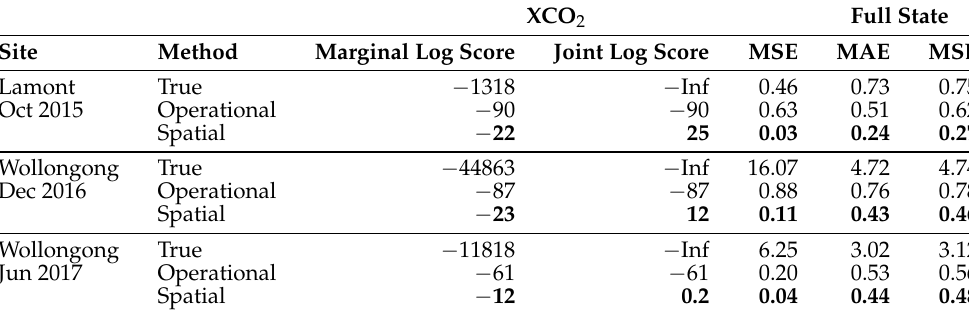
. 2 and the full state vector, as well as the mean 2 XCO 2 Full State